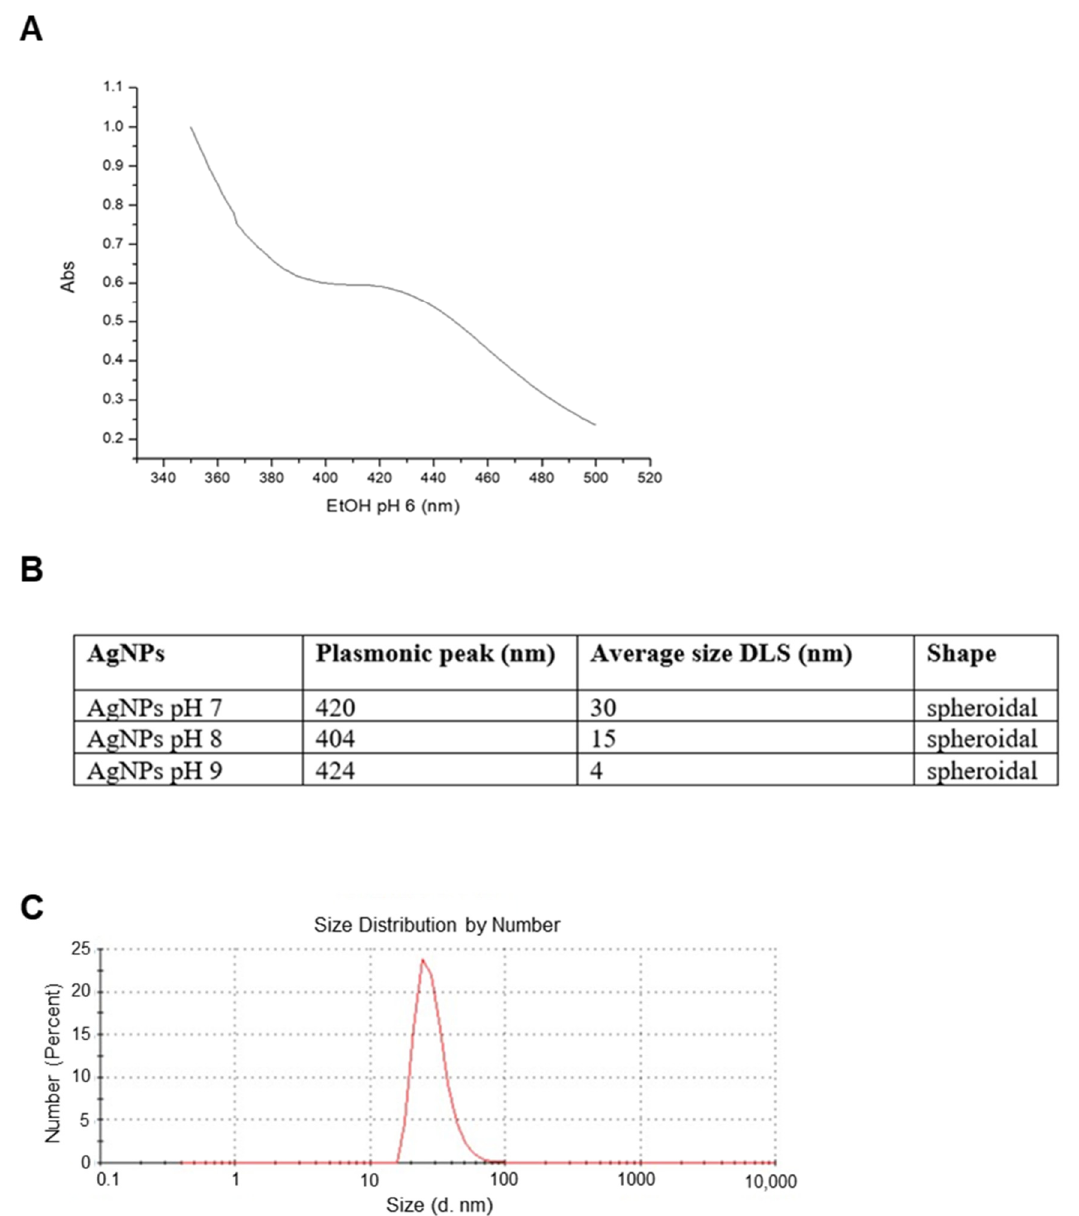
Figure 1. Artemia -AgNPs characterization. ( A ) Table indicating the major properties of all three nanoparticles. ( B ) Selected UV-vis spectrum for AgNPs at pH 7 showing the plasmonic peak at 420 nm. ( C ) Selected DLS measurements for AgNPs at pH